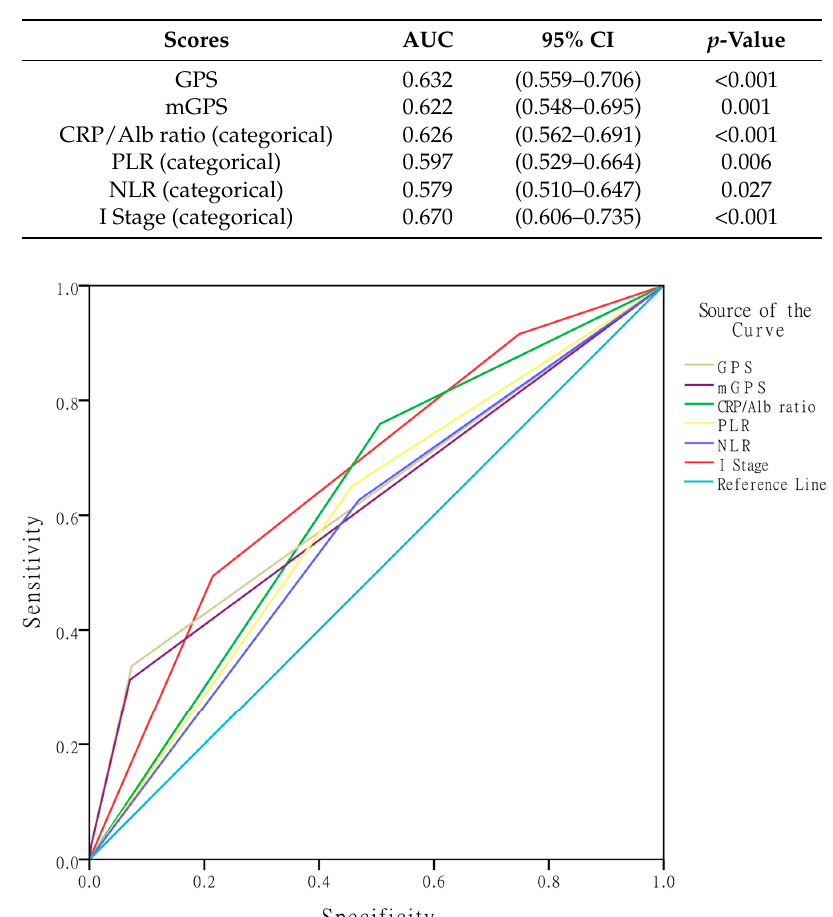
Table 4. Comparison of the areas under the curves (AUCs) for the inflammation-based prognostic scores.